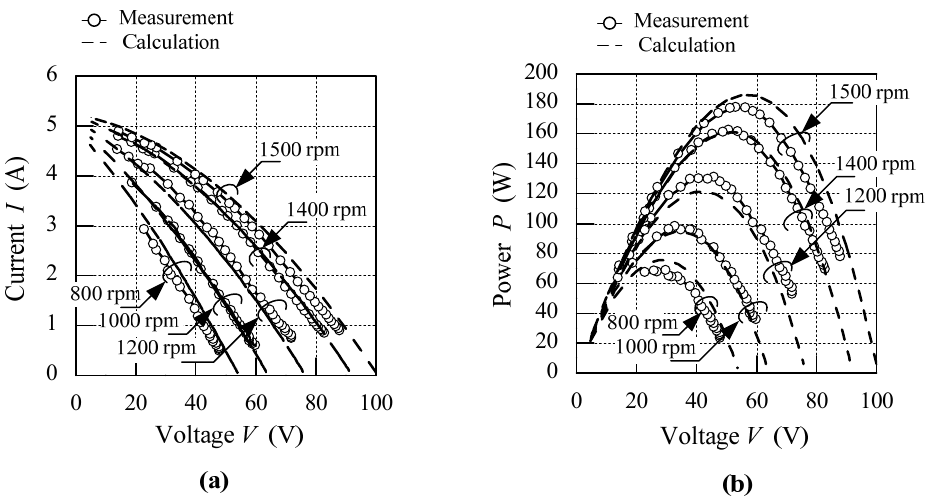
Figure 5. Relationship between voltage, current and power: ( a ) v ‐ i characteristics; ( b ) v ‐ p characteristics.